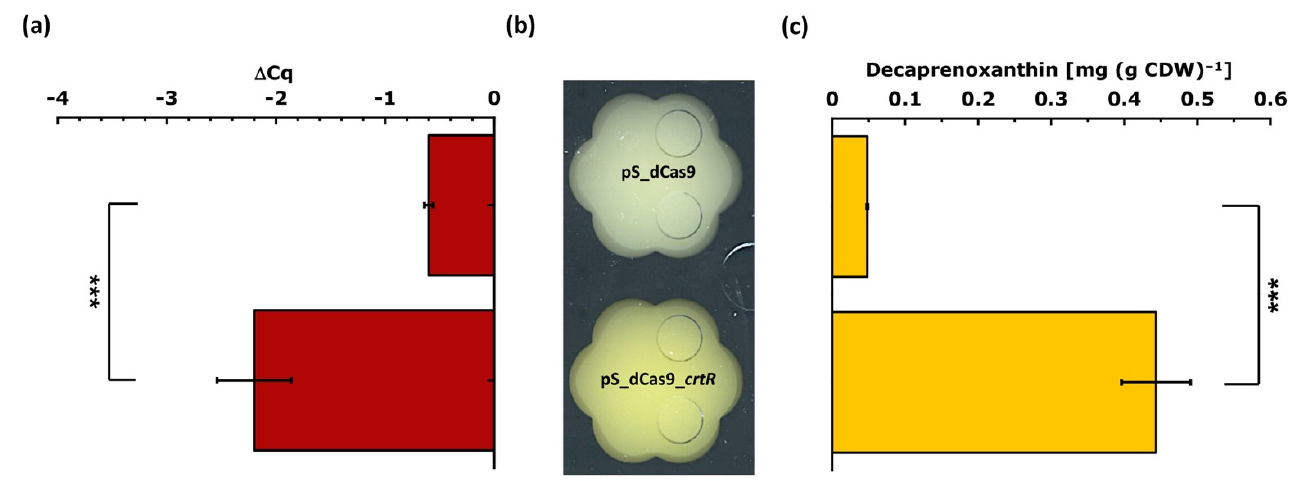
Figure 2. Testing the CRISPRi system for identification of metabolic engineering targets relevant for carotenoid production. Strain C. glutamicum MB001(pS_dCas9_ crtR ) for CRISPRi-mediated repression of crtR was compared to the empty vector carrying control strain MB001(pS_dCas9) with respect to ( a ) crtR RNA levels, ( b ) color phenotypes, and ( c ) cellular decaprenoxanthin content. For qRT-PCR analysis, exponentially growing cells were harvested and sigA was used as a reference ( a ). The color phenotype ( b ) was judged by visual inspection after growth in the Biolector ® flowerplate microcultivation system. Cells were grown in 40 g L − 1 of glucose CGXII minimal medium for 28 h and induced at 0 h with 1 mM IPTG and 0.25 µg mL − 1 of aTc. The cellular decaprenoxanthin content ( c ) is given as ß-carotene equivalents, as determined by HPLC analysis. Mean values and standard deviations of three biological replicates are given. The p -value of <0.001 (***) was calculated using Student’s t -test (two sided, unpaired).